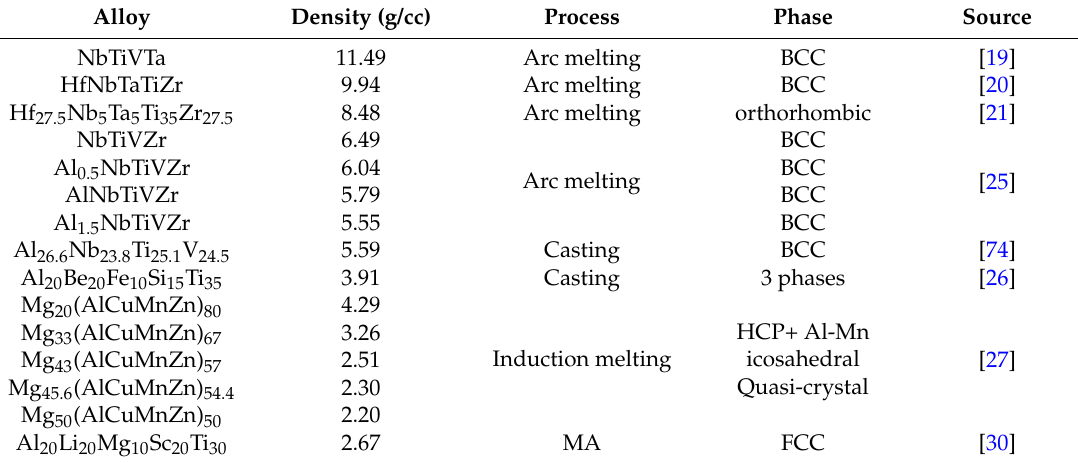
Table 2. List of HEAs from high density to low density (LWHEA), their processing routes and various solid solution phases observed in